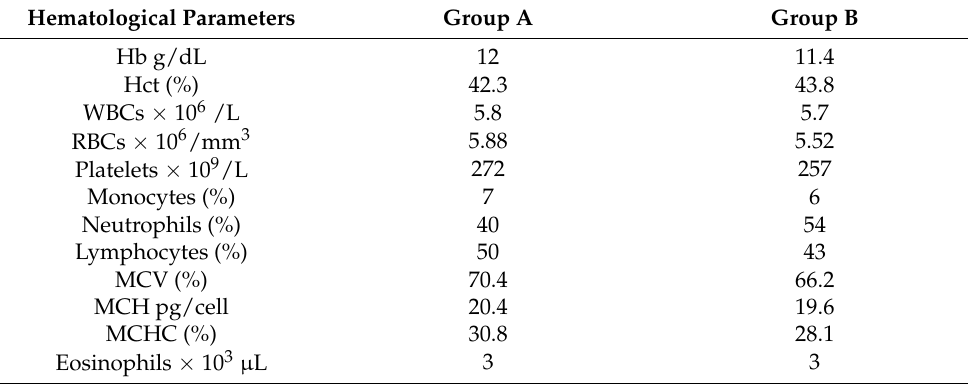
Table 6. Blood hematological analysis of control and tested rat groups.